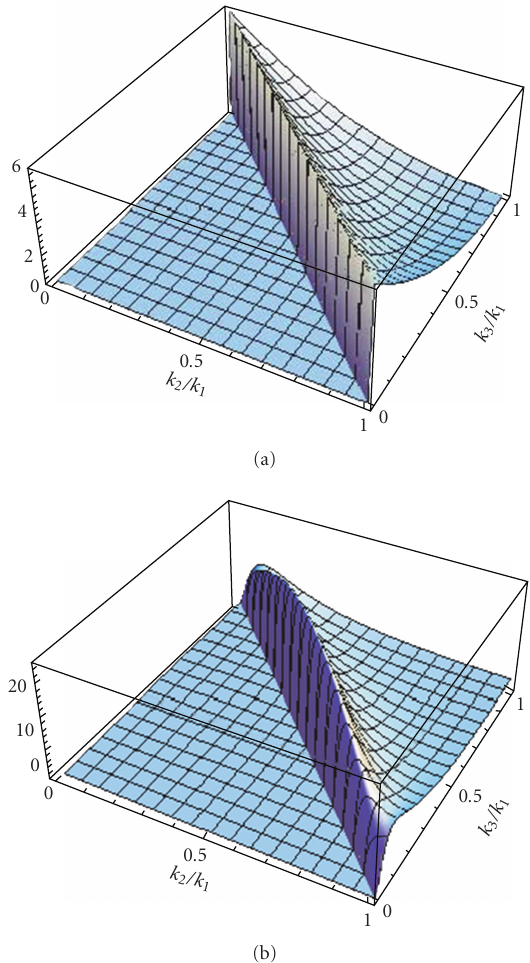
Figure 11: Two ansatz for the folded shape. (a) Equation (155) and (b) Equation (156) with k c /k 1 = 0 .